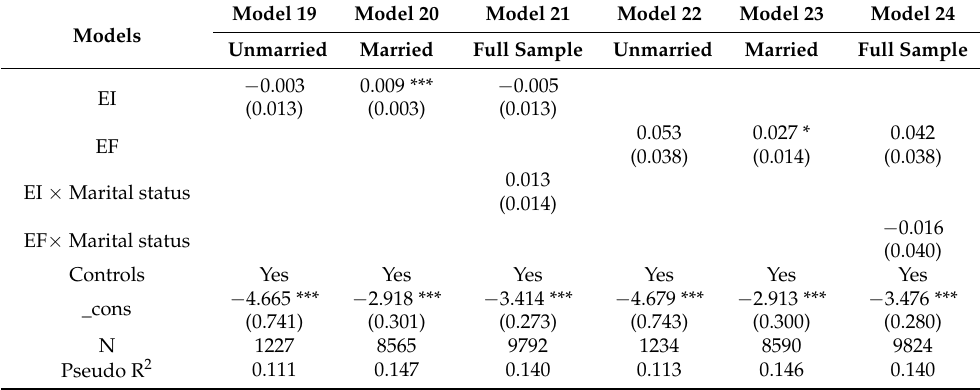
Table 5. Comparison of different marital